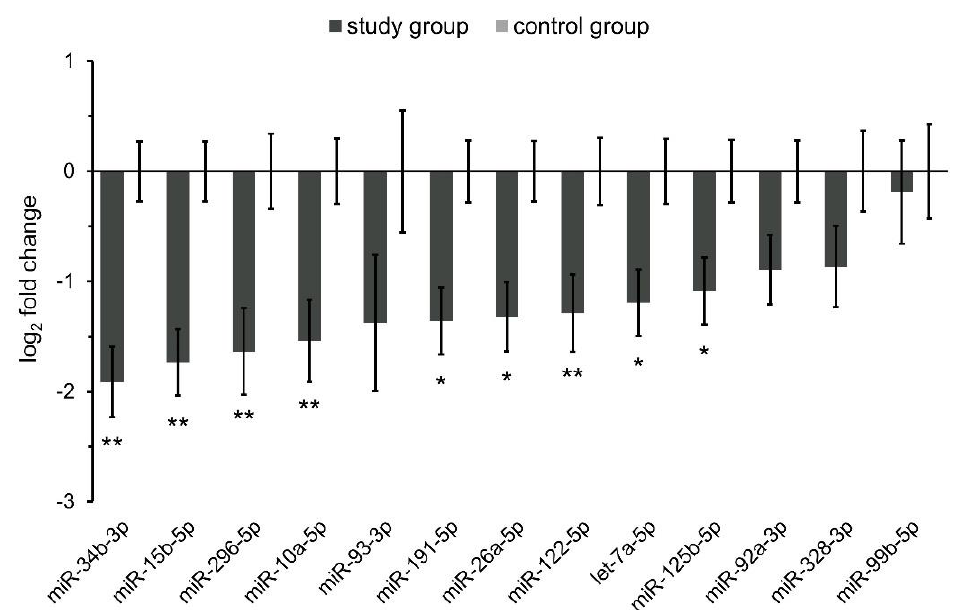
Figure 1. MicroRNA (miRNA) expression levels in spermatozoa from patients with teratozoospermia. Expression profiles of 13 selected miRNAs in spermatozoa from the study group ( n = 13) compared to the controls ( n = 15). The bars represent the means of log 2 fold change values ± SDs. Data were evaluated using the unpaired Student’s t -test. An asterisk indicates significance with respect to the control group (* p < 0.05; ** p < 0.01). A p -value of < 0.05 was considered statistically